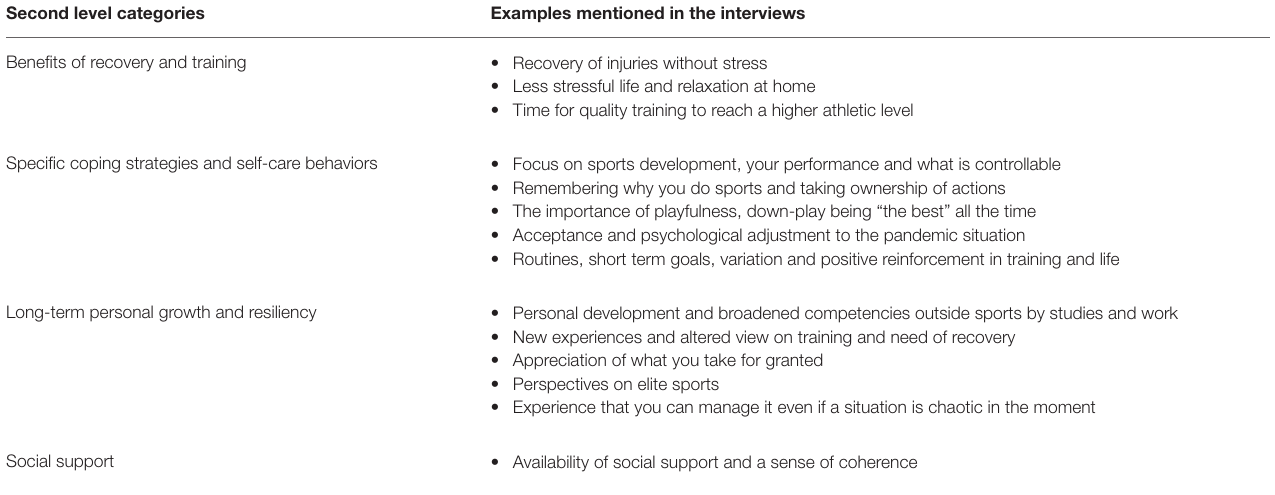
TABLE 3 | Second main theme: protective